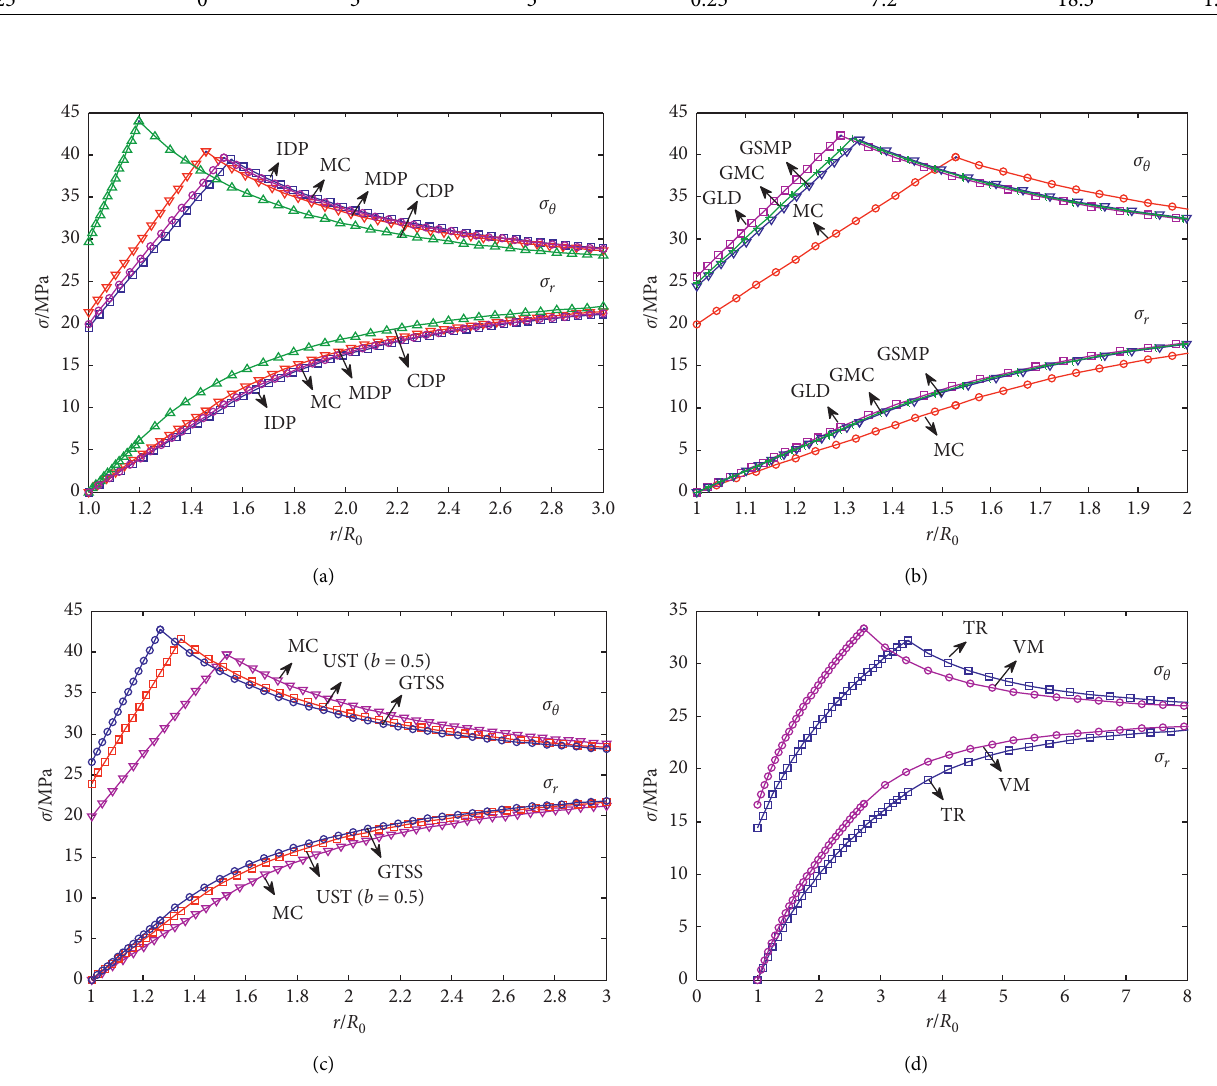
Figure 8: The stresses distributions law under different criteria. Table 4: The radius of plastic zone and critical inner pressures under different